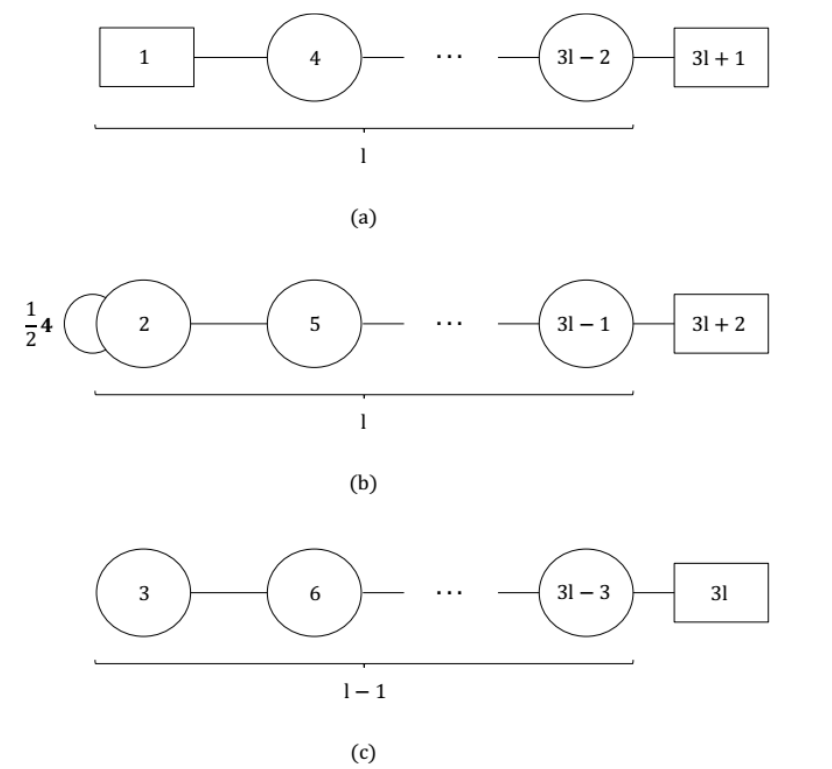
Figure 6 . Quivers of the 4 d gauge theory that is expected to exist, on a generic point on the Coulomb branch spanned by the operators descending from the tensor multiplets, for theories resulting from the Stiefel-Whitney compacti(cid:12)caton of the theories in (cid:12)gure 5.